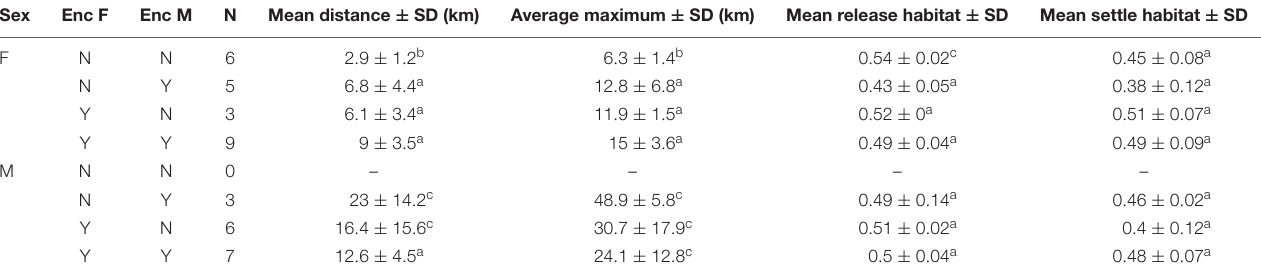
TABLE 4 | The mean of the mean and maximum distances that reintroduced fishers traveled from their release sites through the first 500 days of